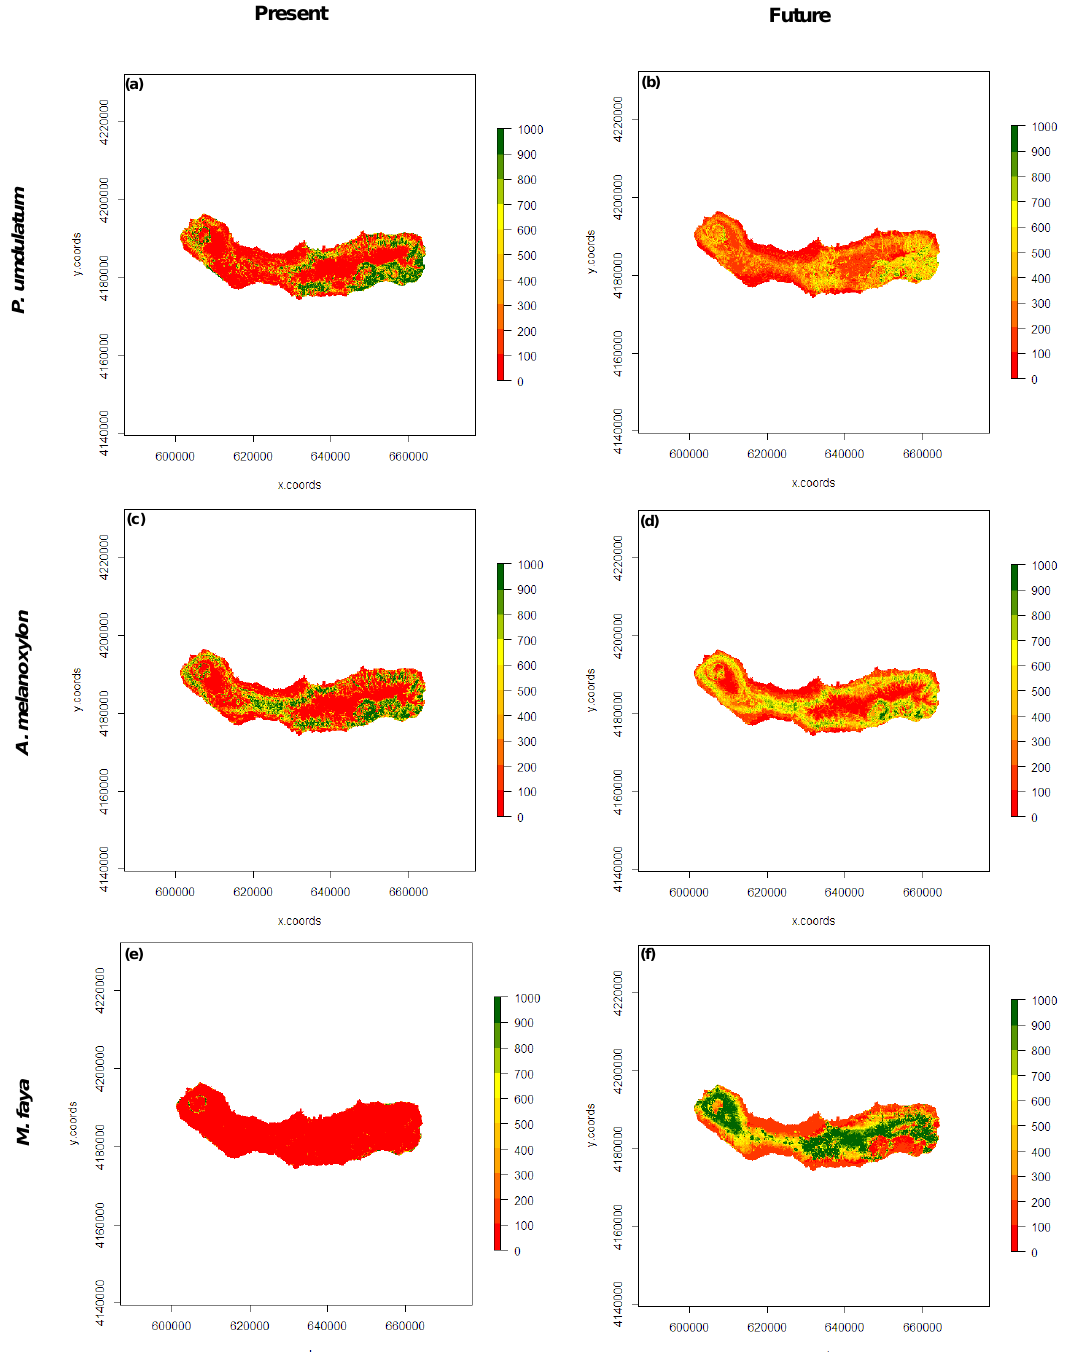
Figure 9. Present and future species distribution maps modelled for S ã o Miguel Island: ( a , b ) P. undulatum , ( c , d ) A. melanoxylon, and ( e , f ) M. faya . Evaluation measure, AUC: Area under the receiver operating characteristic curve. EGV set 2. A probability scale from 0 to 1000 was used to facilitate map reading.